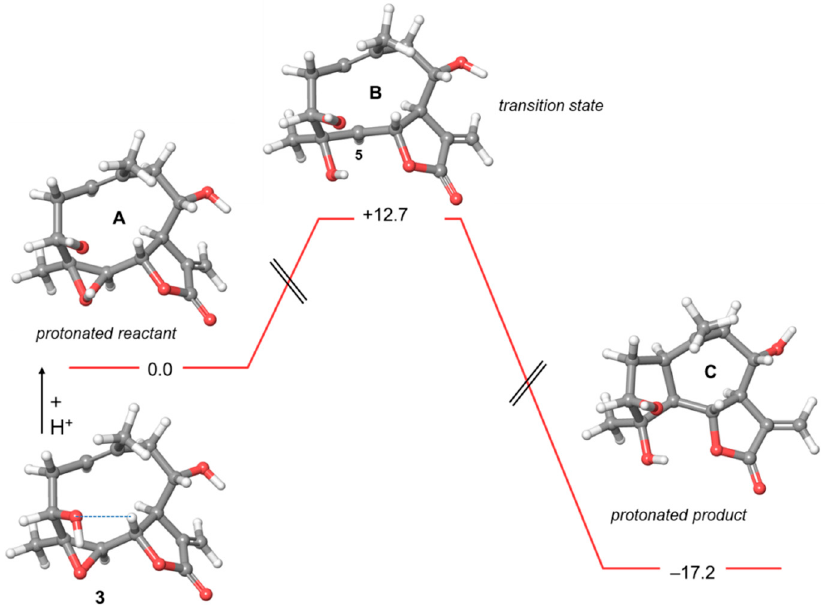
Figure 2. Energy profile of the putative transannular cyclization of 3 . Relative energies are reported in kcal/mol. The hydrogen bonding interaction O-3 . . . H-6 is represented with a dashed line.